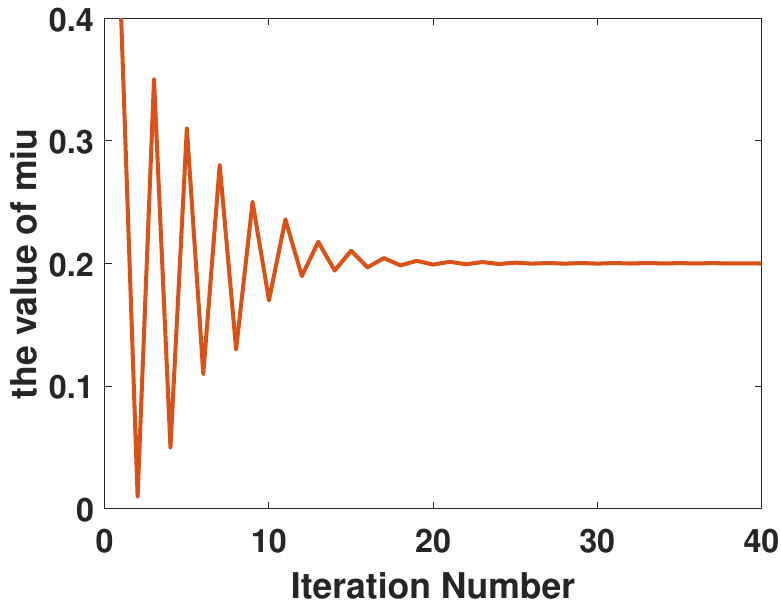
Figure 21. The waveform under the high − order